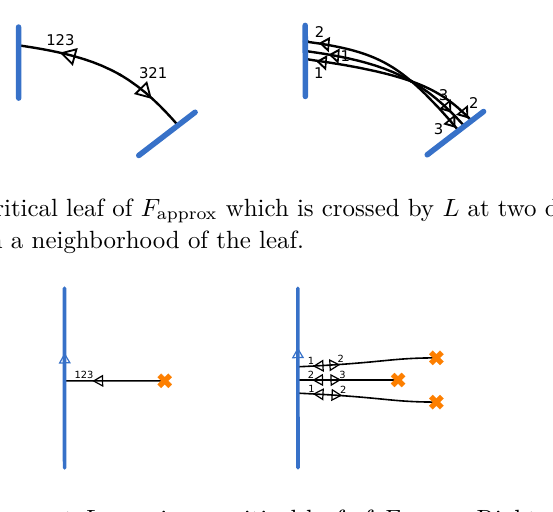
Figure 34 . Left: a link segment L crossing a critical leaf of F approx . Right: a cluster of 3 detours in a neighborhood of this